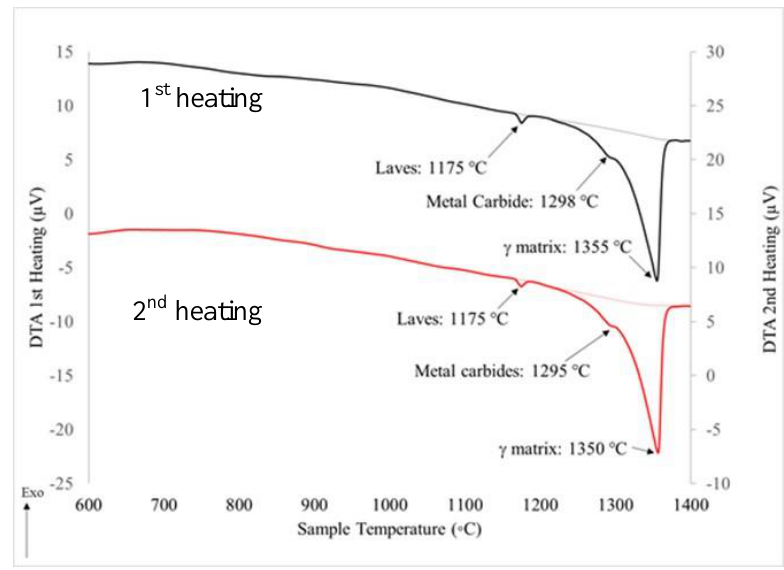
Figure 4. DTA heating cycles for AB Inconel 718.